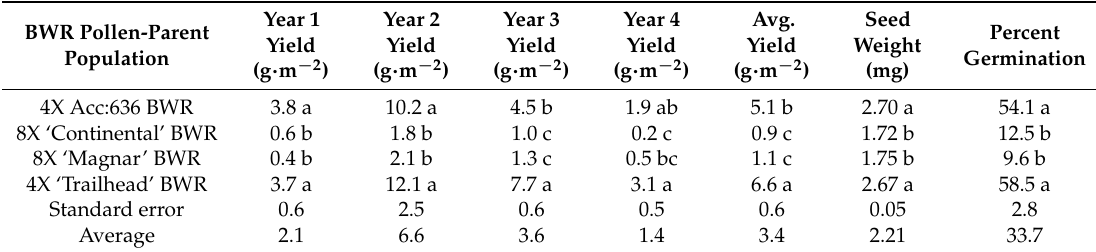
Table 1. Yield, average seed weight, and percent germination of seed harvested from the tetraploid